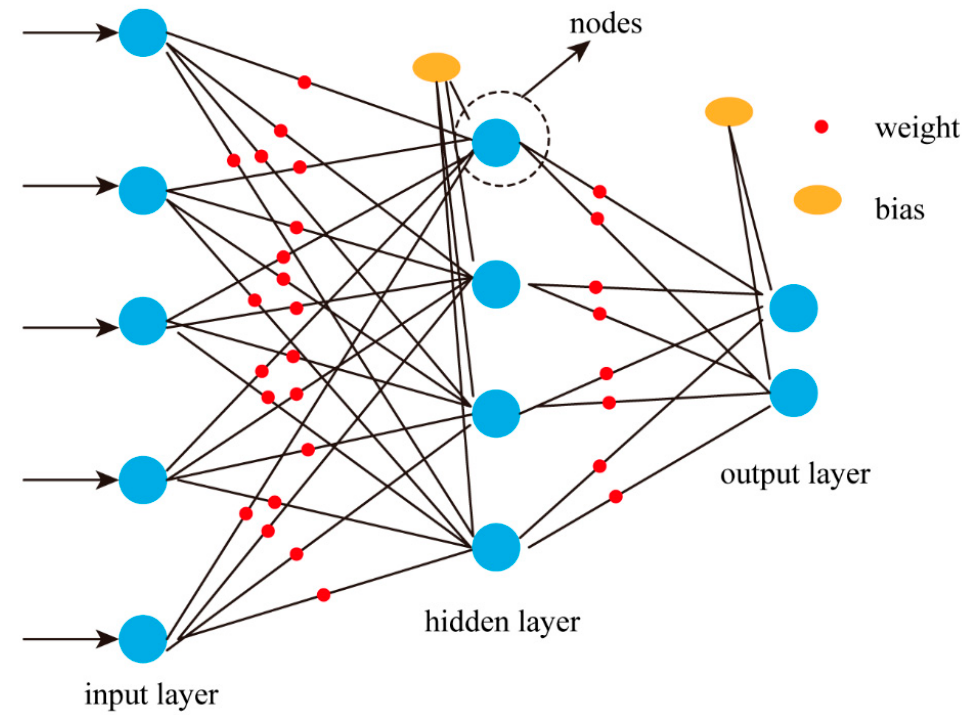
Figure 1. Illustration of a three-layer feedforward neural network.